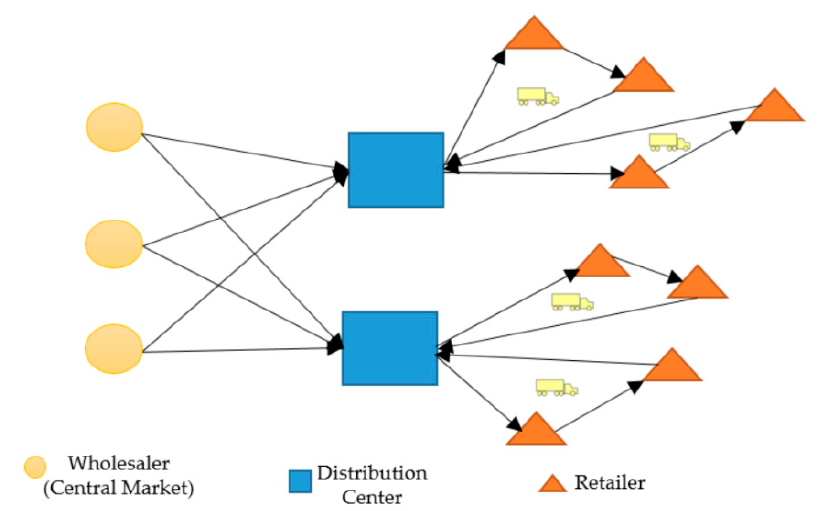
Figure 6. The transport network of scenarios 2–8 (TO BE).